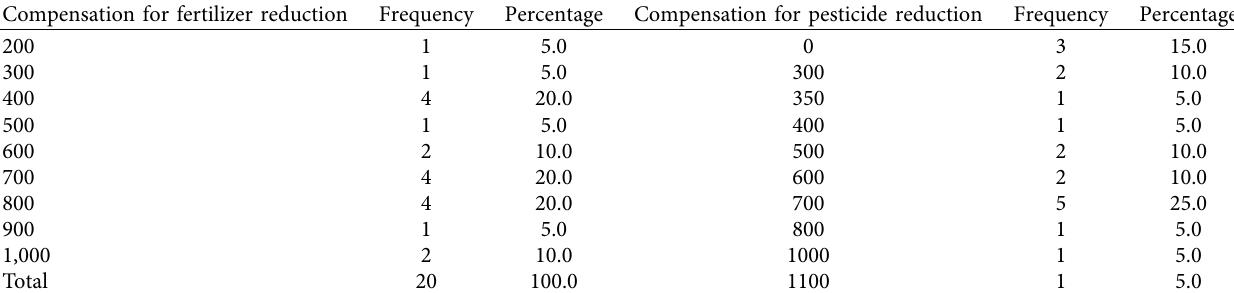
Table 1: Compensation amount that can incentivize farmers’